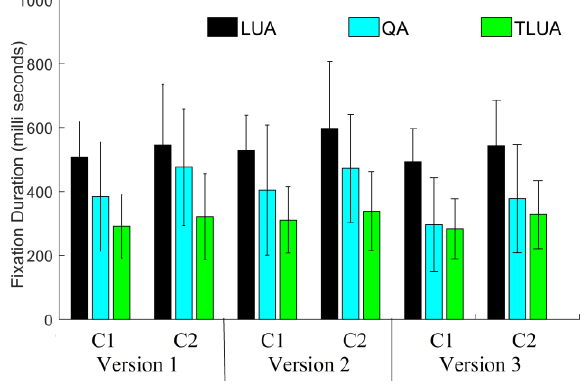
Fig. 14 Average fixation durations in LUA, QA and TLUA for 3 different dDSST versions and 2 age